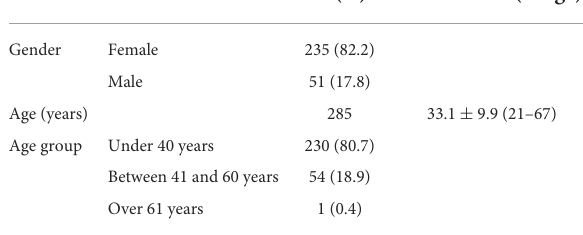
TABLE 3 Results of the GHQ-28 and WHO-5 questionnaires ( n =